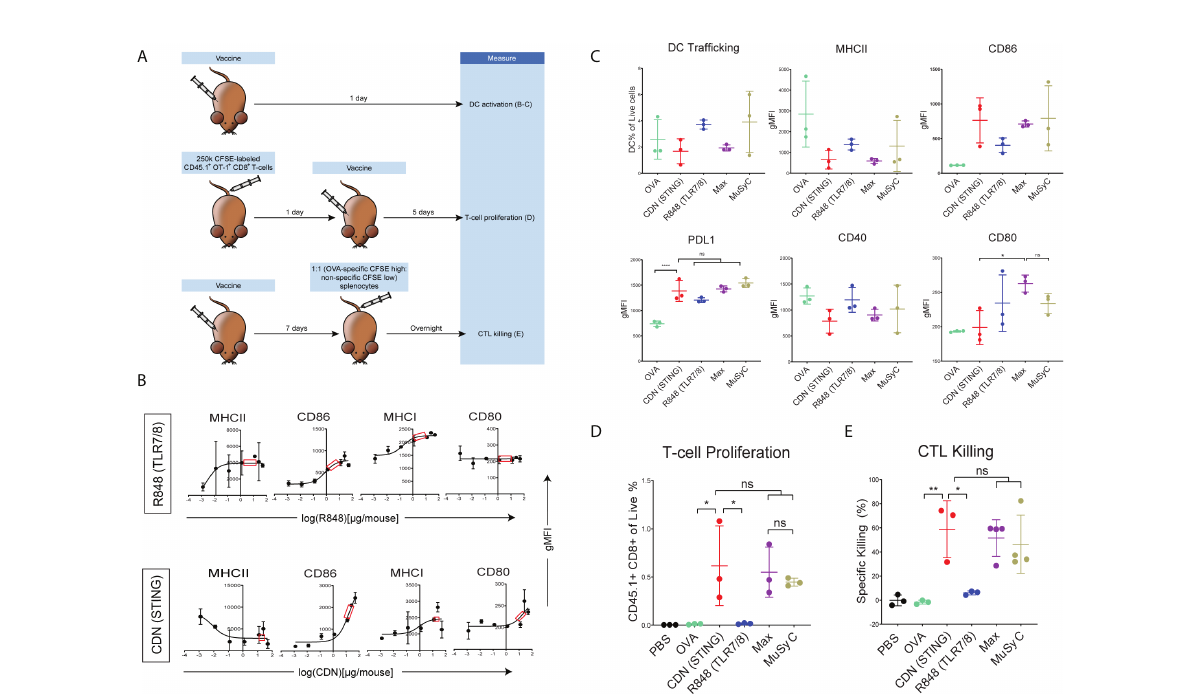
FIGURE 3 CDN-based vaccines induce optimal T- cell priming. (A) In vivo T-cell priming schematic. (B) Female C57BL/6 mice (n = 2) were subcutaneously injected with 20 m g offull-length ovalbumin protein vaccine with increasing doses of R848 (TLR7/8) and CDN (STING). CD11c + MHCII+ DC activation status is shown. Saturating doses of 2 µg was chosen for R848 and 20 µg for CDN for all remaining in vivo experiments. (C) Female C57BL/6 mice (n = 3) were injected with OVA alone or OVA plus R848, CDN, Max-dose (R848 of 2 µg per mouse + CDN of 20 µg per mouse), and MuSyC-dose (R848 of 0.2 µg per mouse + CDN of 20 µg per mouse). The gMFI for activation/inhibitory receptors (CD80, CD86, PDL1, MHCII, and CD40) and the percentage of murine DCs of total live cells in the lymph node were measured. (D) A total of 250,000 CFSE-labeled CD45.1+ OT-1 CD8 T cells were intravenously injected into female C57BL/6 mice (n = 3). Mice were injected with the corresponding vaccine. The percentage of CD45.1+ of the live cells is shown. (E) C57BL/6 mice (n = 3 – 4) were subcutaneously injected with PBS or the appropriate vaccine. CFSE high